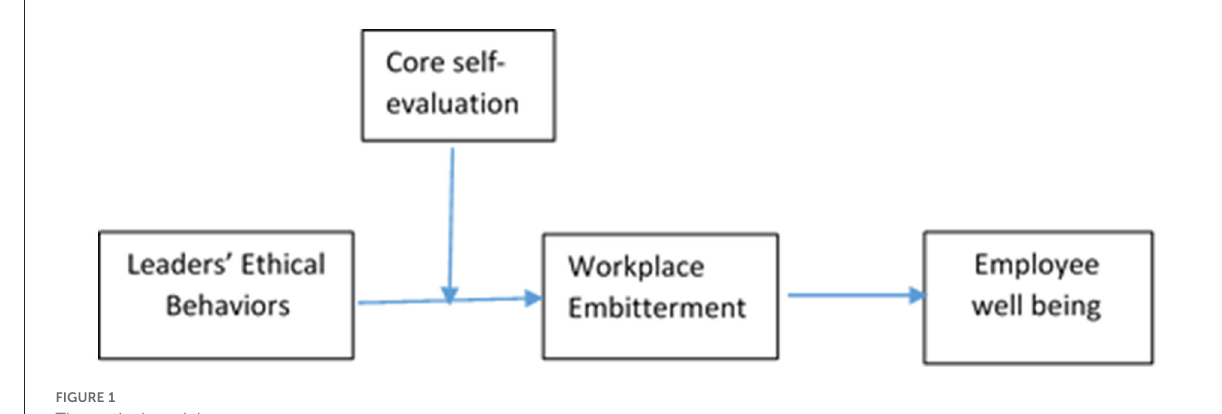
FIGURE1 Theoretical